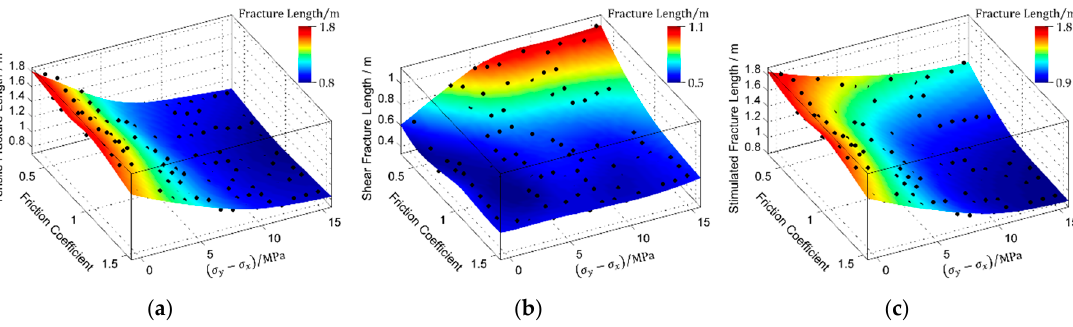
Figure 6. Variations of fracture lengths with stress difference and the friction coefficient between fracture surfaces. ( a ) The variation of the tensile fracture length; ( b ) The variation of the shear fracture length; ( c ) The variation of the stimulated fracture length, i.e., the length of the fractures that are either tensile or shear fractures. In these figures, each black point represents the result of a simulation. The colored surfaces represent the smoothed results.